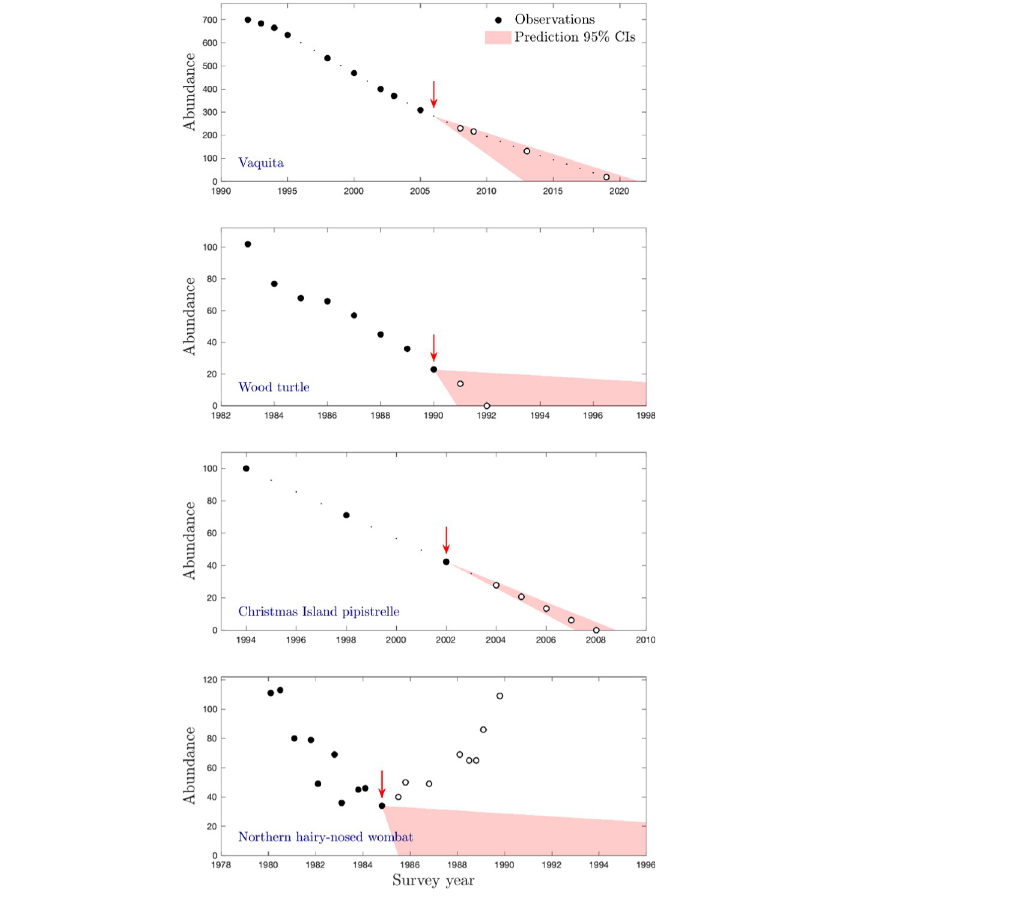
Fig 2. Results of applying the optimal decision method to four declining case-study populations. In each case, the red arrow shows the point in time at which the method recommended ex situ , in toto action be undertaken, based on the range of linear declines shown in red. Closed markers show observations preceding the decision, open circles show observations after the decision would have been recommended.